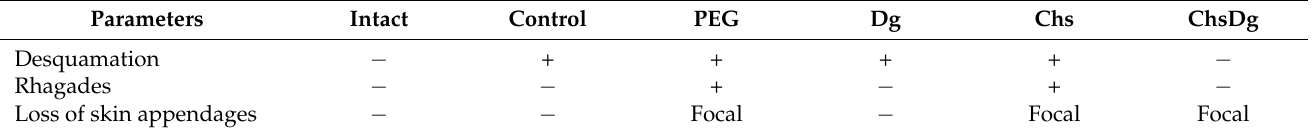
Table 2. Skin status regarding desquamation, rhagades, and loss of skin appendages.